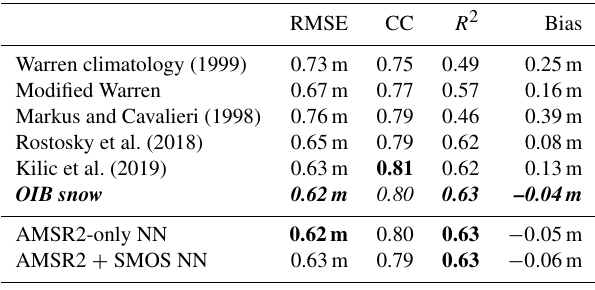
Table 3. RMSE, correlation, coefficient of determination and bias between CryoSat-derived SIT using different snow products and OIB-measured snow (italic) for all data. The best score of each cat- egory is highlighted in bold.